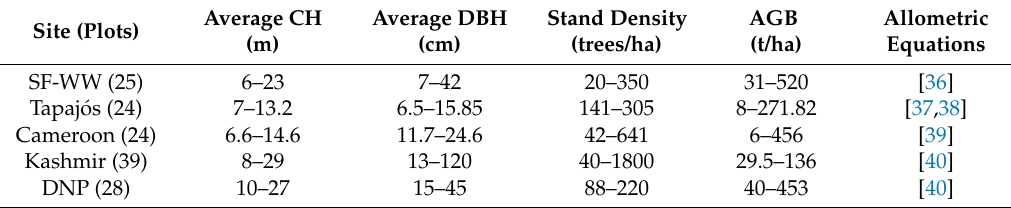
Table 2. Details of field measured forest properties (averages) used in this study. Average Site (Plots)